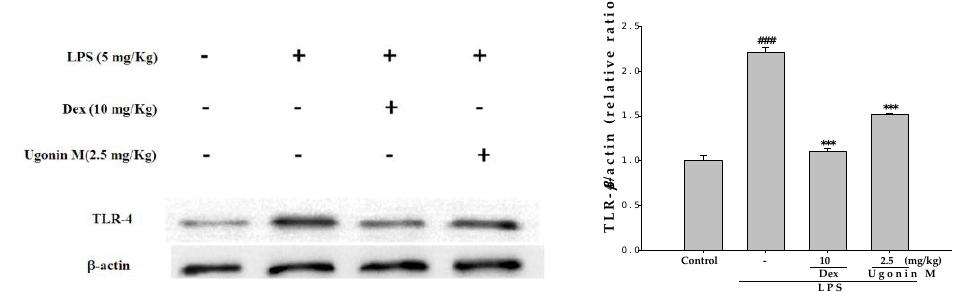
Figure 10. Effect(s) of Ugonin M on LPS-induced TLR-4 expression in lung tissues. The fold change in TLR-4 expression between the pretreated and the control groups was calculated. Data represent the mean ± SD for three different experiments performed in triplicate. ### p < 0.001 was compared with sample of control group (One-way ANOVA followed by Scheffe’s multiple range tests). *** p < 0.001 was compared with the LPS-only group.